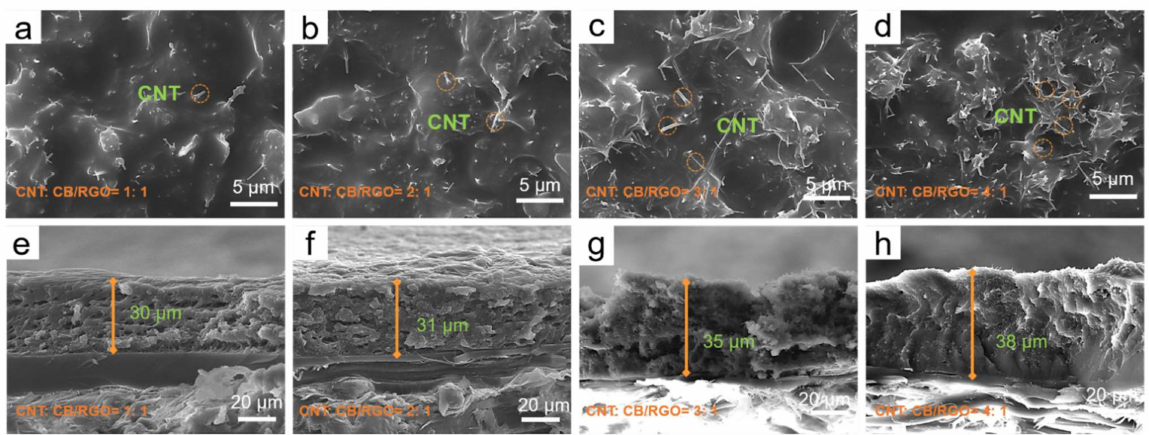
Figure 3. The micromorphology of the surface and cross-section of the impregnation layer of dif- ferent slurries ( a , e ): CNTs:CB/RGO = 1:1; ( b , f ): CNTs:CB/RGO = 2:1; ( c , g ) CNTs:CB/RGO = 3:1; ( d , h ) CNTs:CB/RGO =